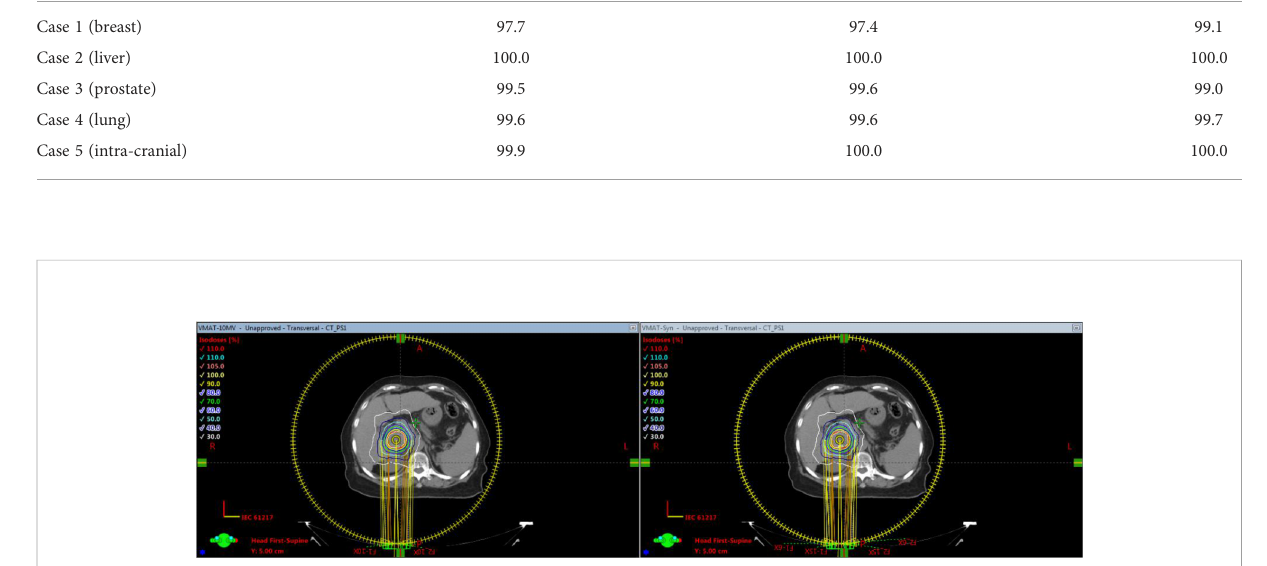
FIGURE 6 Comparison of dose distributions of VMAT plan for Case 2 (Left: TB-10MV; Right: E syn